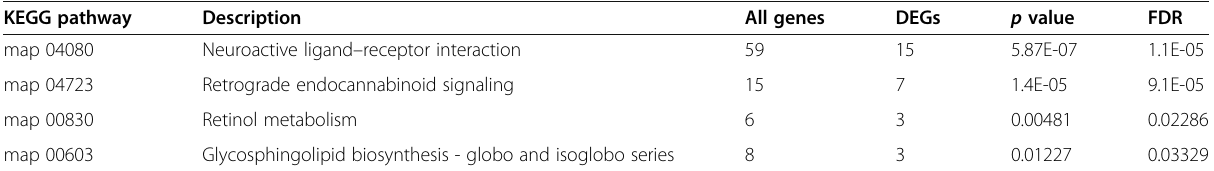
Table 1 Results of KEGG pathway analysis. All genes: Number of A. tenuis genes in the pathway. DEGs: Number of DEGs in the pathway KEGG pathway